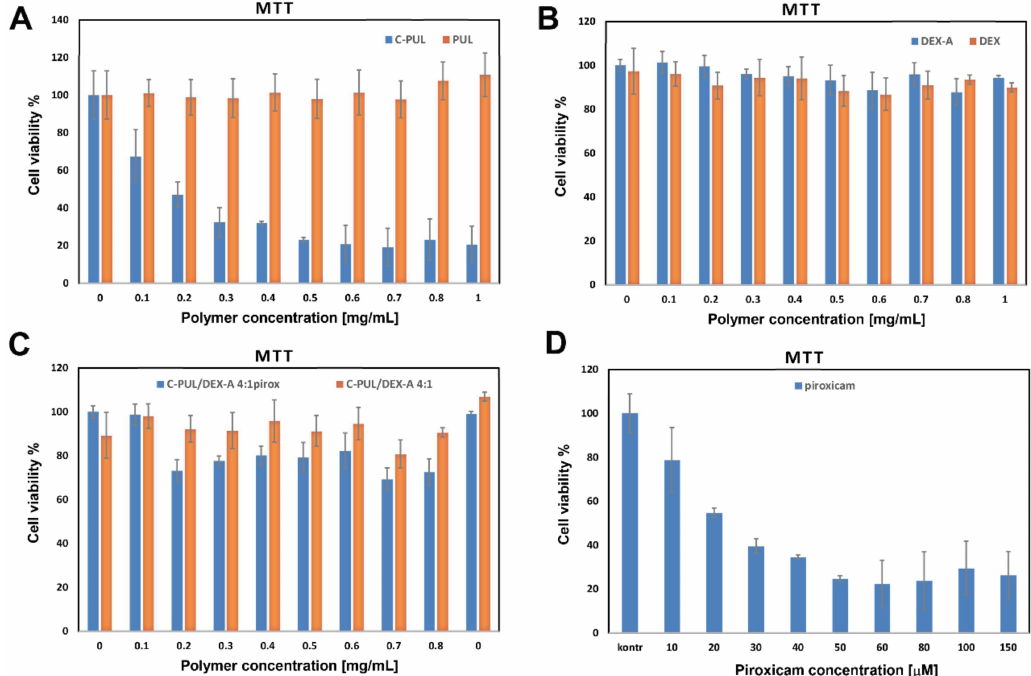
Figure 9. MTT assay test performed for NIH3T3 cells incubated for 24 h with ( A ) PUL and C-PUL; ( B ) DEX and DEX-A; and ( C ) 4:1 C-PUL / DEX-A nanogel systems without and with entrapped piroxicam ( D ) piroxicam in DMSO. Cell viability is expressed as a percentage of the control, which was defined as 100%. The error bars represent mean and standard deviations of the single experiments performed in triplicate ( n = 3). DEX-A, anionic dextran